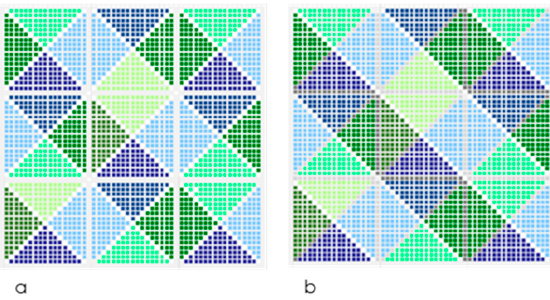
Figure 3. Two perceptions of a 2D mosaic with a resolution 56 × 56 pixels. Mosaic ( a ) shows pixels with four different colors. Same color pixels are grouped and separated by white pixels forming triangles; Mosaic ( b ) shows vertical and horizontal white lines dimmed to gray.